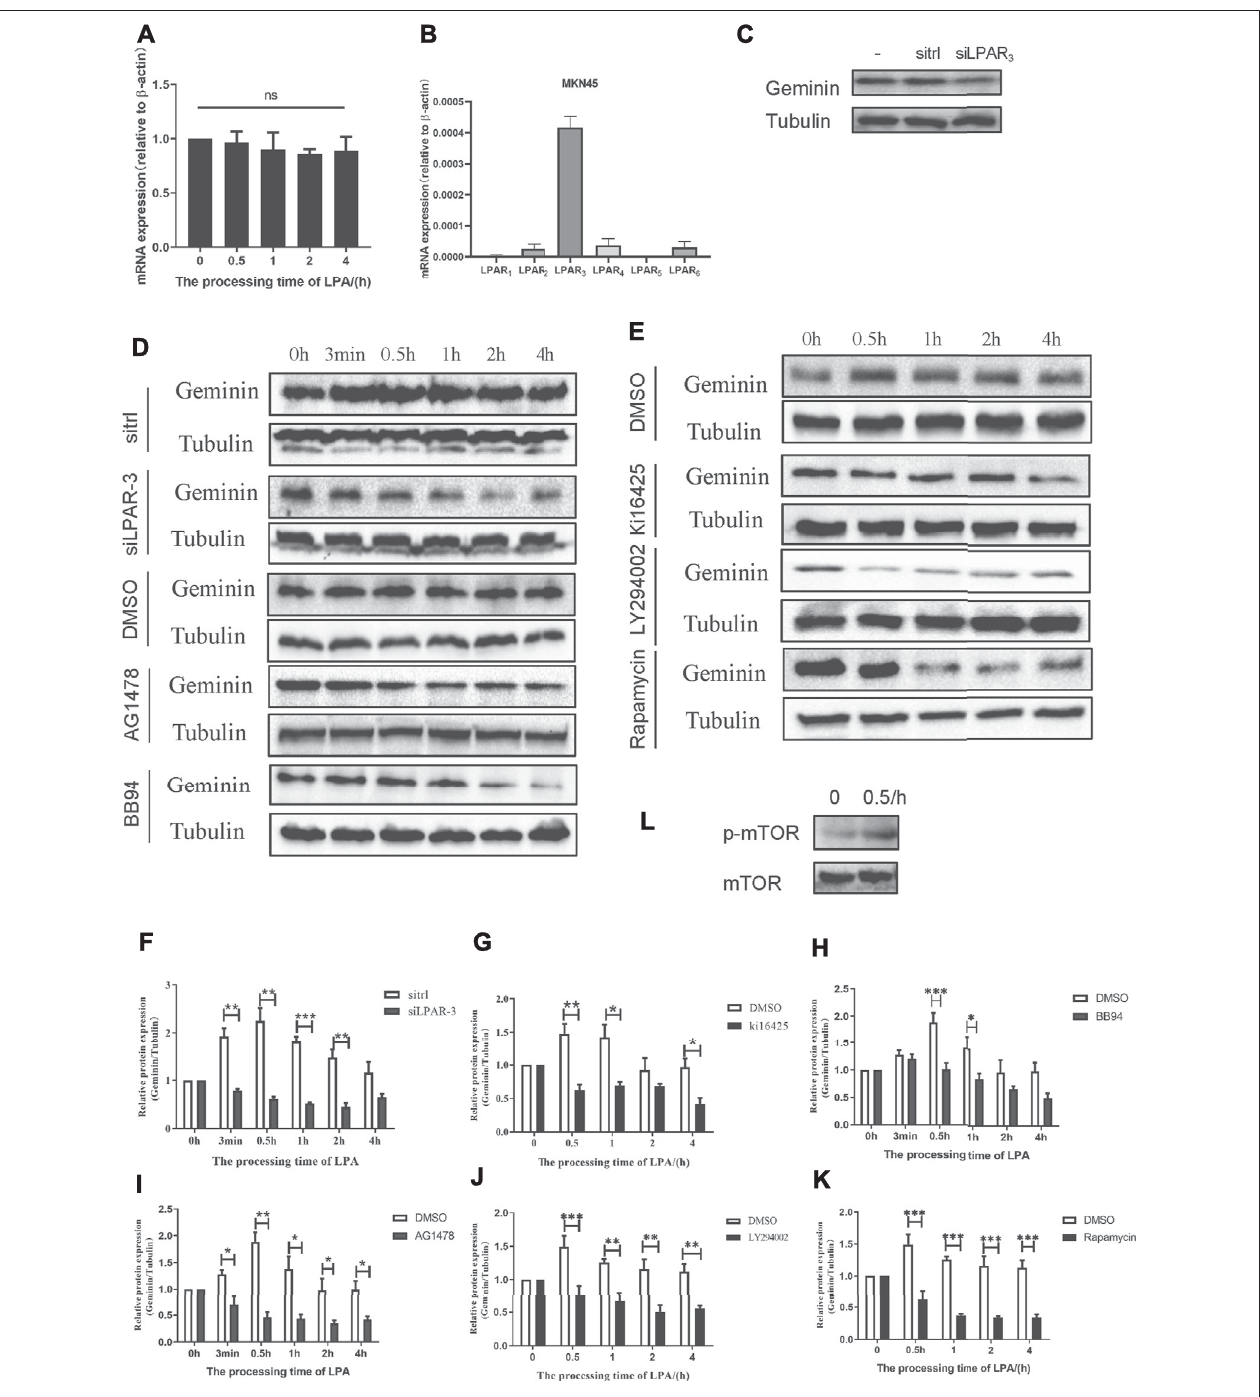
FIGURE 6 | LPA potentiates geminin stability through LPAR 3 /MMP S /EGFR/PI3K/mTOR signaling axis in MKN45 cells. (A) mRNA expression of geminin under 10 µMLPAtimegradient.Densitometryofthreeindependentexperimentswasperformednormalizedtoactinandexpressedasratioof0h;mean ± SD(ANOVAtestand Dunnett ’ s multiple comparisons test). (B) mRNA expression of LPARI-6 in MKN45 cells. (C) Geminin protein levels after transfectedwith or without sitrl/siLPAR3 for6 h, and the cells were cultured for another 48 h in the total medium until harvested. (D – E) Gemimin protein level after pretreated with DMSO (vehicle, 0.1%), Kil6425 (10 µM), BB94 (10 µM), AG1478 (250 nM), LY294002 (10 µM), or rapamycin (100 nM) for 30 min, and stimulated with 10 µM LPA time gradient. In siRNA-silencing experiments, cells were transfected with either siGL or siGEM for 6 h and then cultured for another 48 h. (F – K) Quanti fi cation of geminin protein levels in (D) and (E) . Densitometry of three independent experiments was performed normalized to tubulin and expressed as a ratio of control group; mean ± SD, * p < 0.05, ** p < 0.01, *** p < 0.001 (ANOVA test and Dunnette ’ s multiple comparisons test). (L) Activation level of mTOR and p-mTOR (Ser2448) under 10 µM LPA treatment.